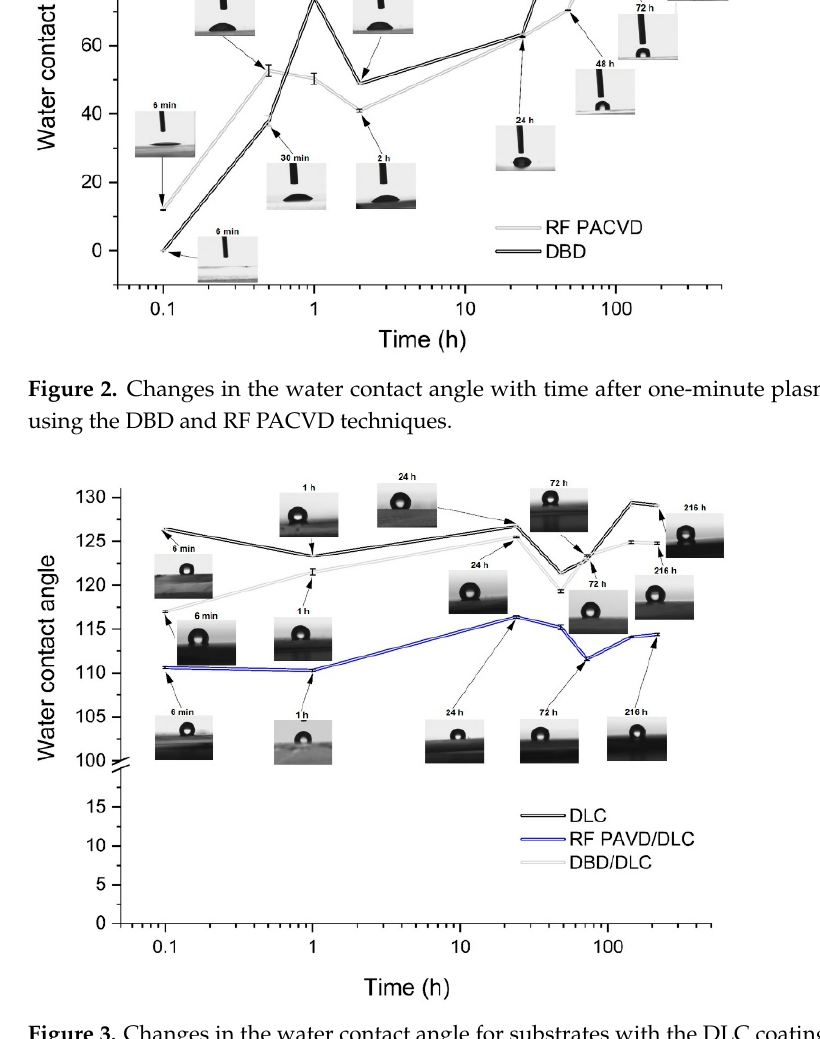
Figure 3. Changes in the water contact angle for substrates with the DLC coating.